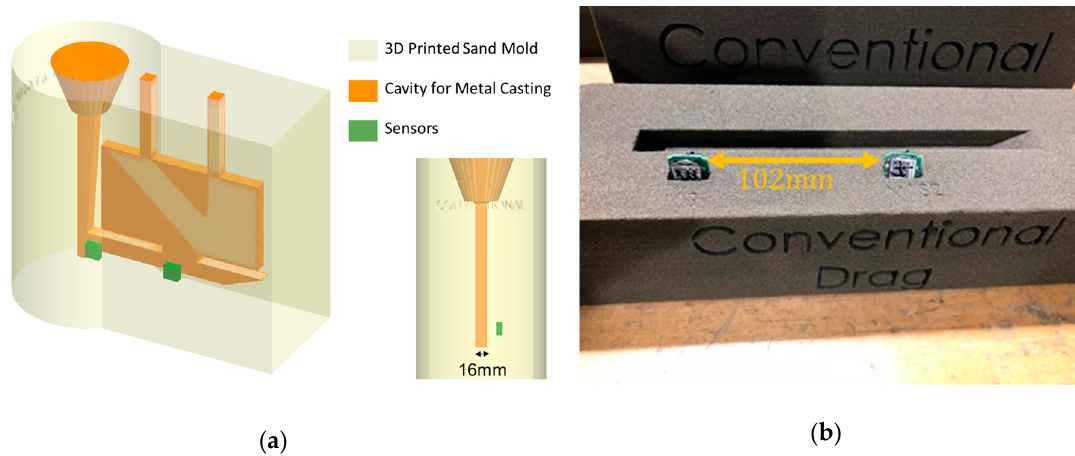
Figure 7. ( a ) Demonstration of location and relative size of sensors within the sand mold. ( b ) Dialog sensors separated by 102 mm and placed half an inch away from runner of SSC.